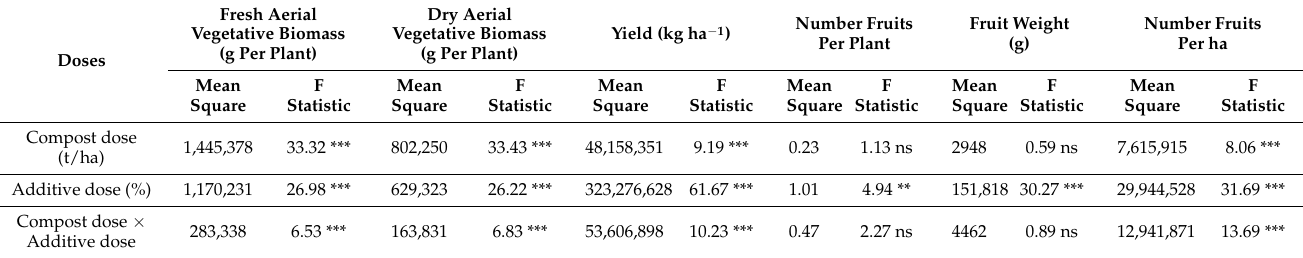
Figure 1. Response of several agronomic variables to the treatments applied in the field trial for the melon crop: yield ( A ), its components ( B – D ), fresh aerial vegetative biomass ( E ) and dry aerial vegetative biomass ( F ). The values are expressed as relative values in percentage, using, as a reference (100%), the control 80. Comparison against control 80 was performed with the Dunnett test (* means significant difference at p ≤ 0.05 with the control 80, ns means not significant difference at p ≤ 0.05 with the control 80). Table 2. ANOVA for yield, yield components and biomass production in the melon crop. The location, the year and the plot were considered random factors, whilst the compost dose and the additive (PGPR + biochar) dose were fixed factors (significance level: *** p ≤ 0.001; ** 0.001 < p ≤ 0.01; ns, not